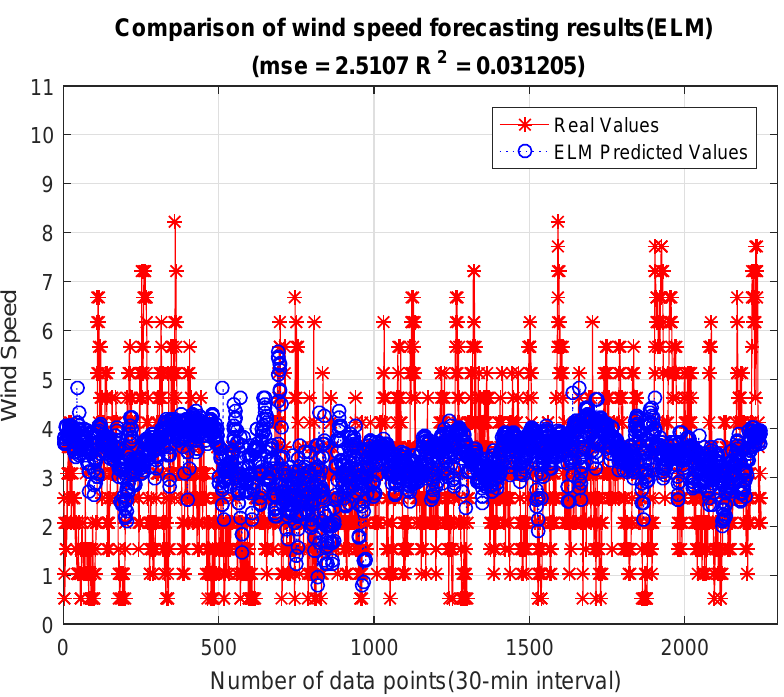
Figure 18. The portraits of comparison of wind speed forecasting results (ELM) in OSWFs in Yangshan port, Shanghai from 22 August 2017 to 22 August 2018 (number of predicted data pieces is 2248).